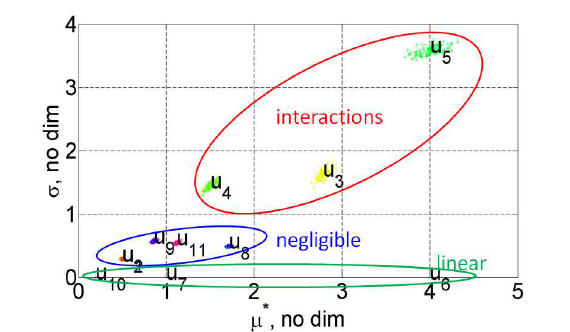
Figure 2: RV ranking from screening design.